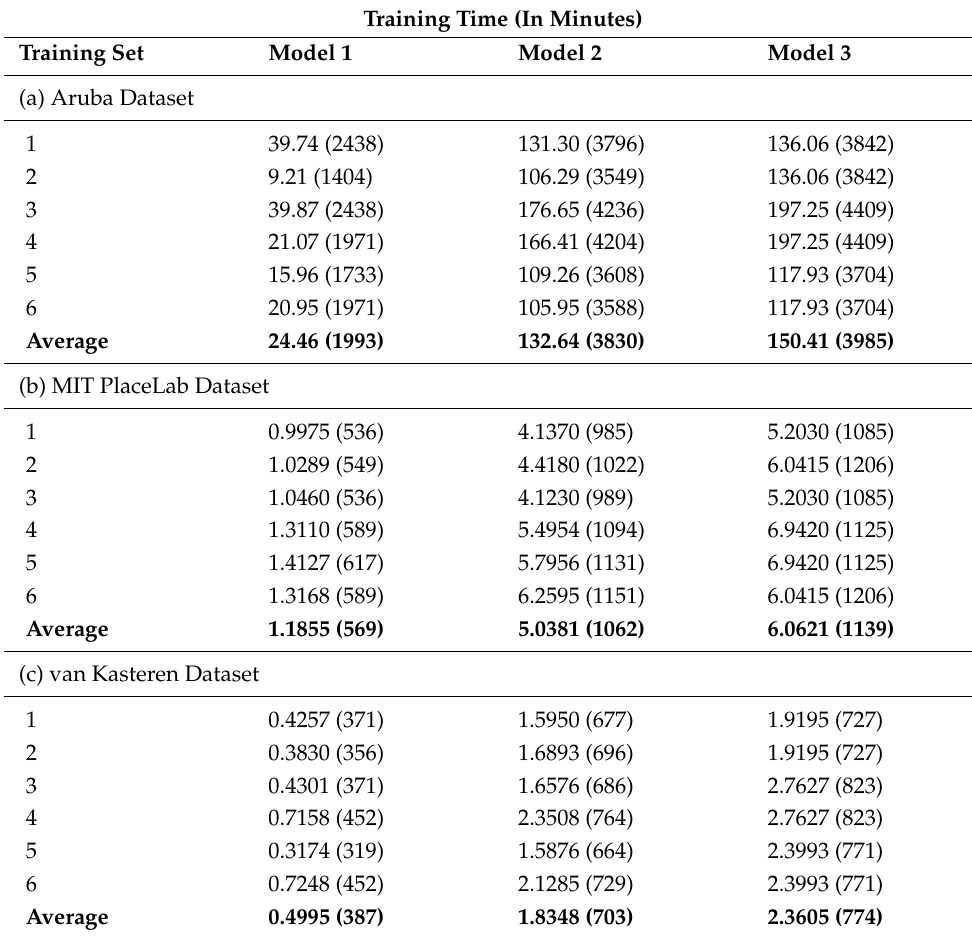
Table 6. Time required for training the PPM. The number of activity instances for each training set is shown in